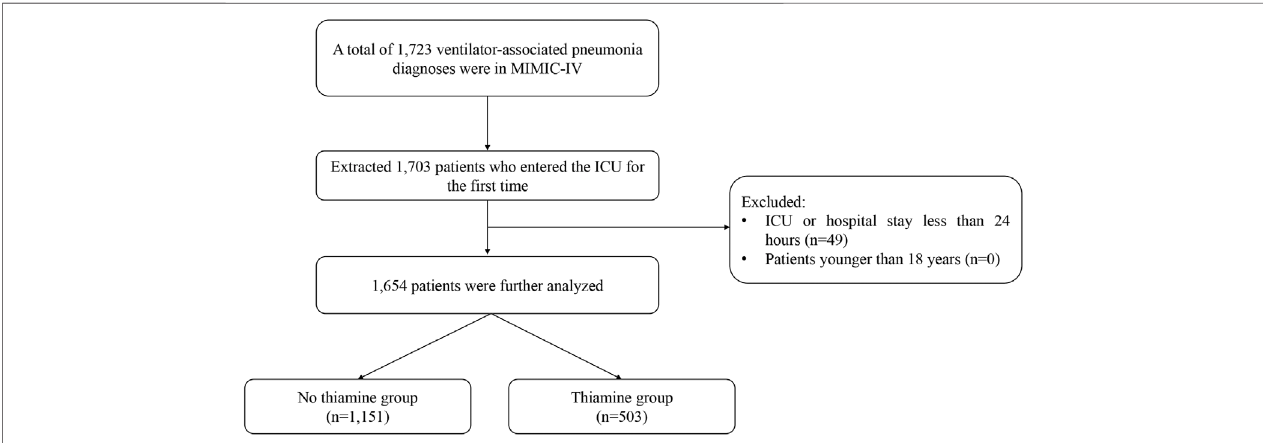
FIGURE 1 | Inclusion and exclusion fl owchart of the